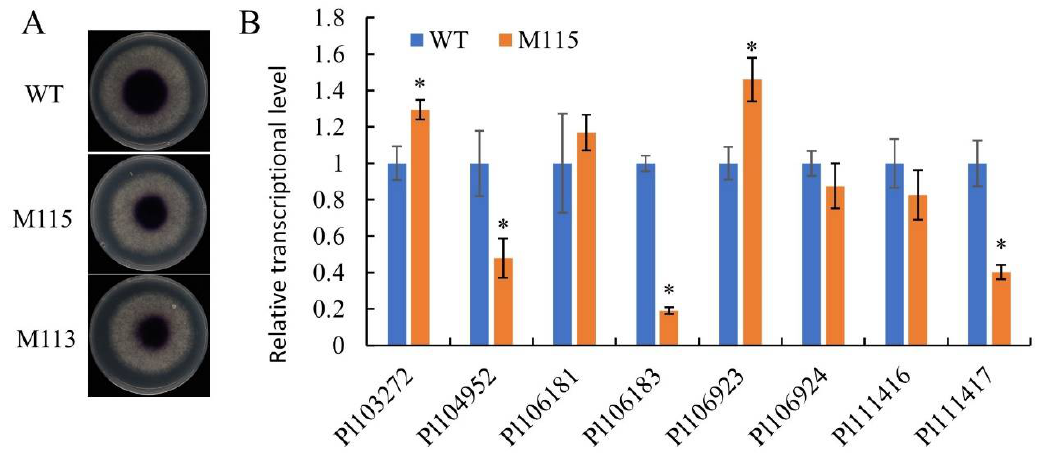
Figure 7. PlMAPK2 regulates laccase activity. ( A ) Mycelial mats of the aforementioned strains were inoculated on media containing 0.2 mM ABTS for 10 days. ( B ) The expression of 8 laccase-encoding genes were analyzed by qRT-PCR. Asterisks indicate significant difference ( t -test, p < 0.01). WT: wild type. The experiments contain three independent biological repeats, each of which contained three replicas.